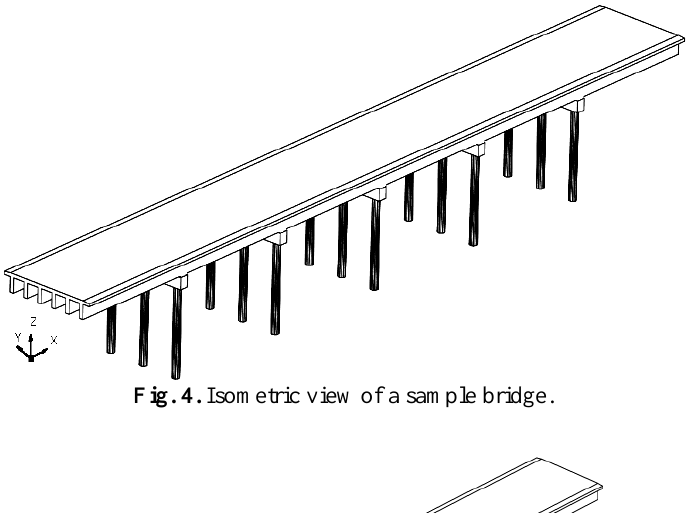
Fig. 3. Support conditions for piers and abutments model.